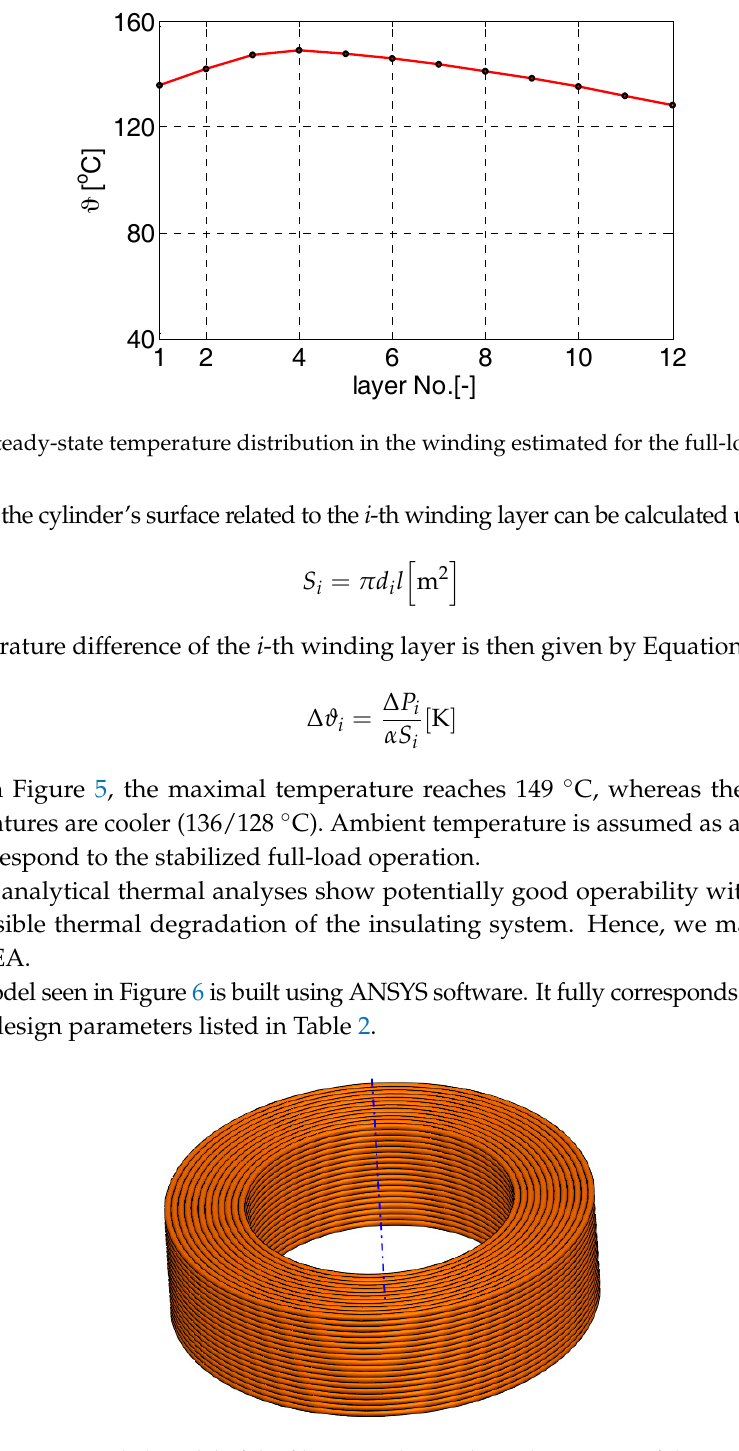
Figure 6. Detailed model of the filter considering the real geometry of the winding.